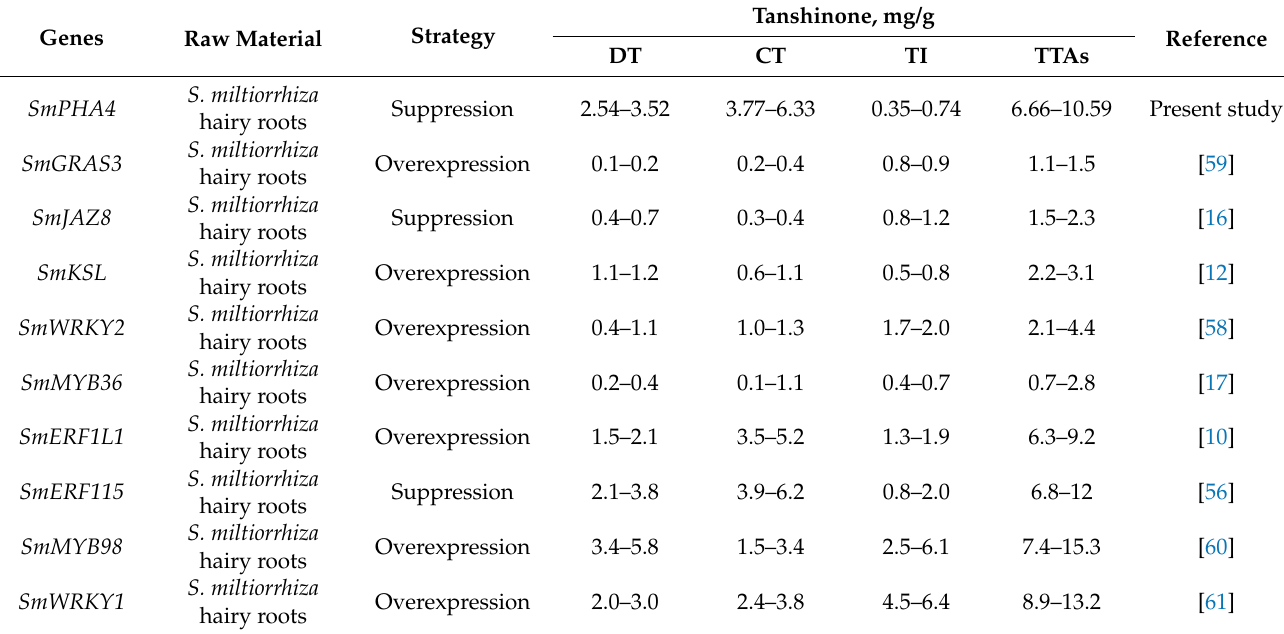
Table 2. Comparisons of tanshinone accumulation of regulatory genes and transcription factors in S. miltiorrhiza a .